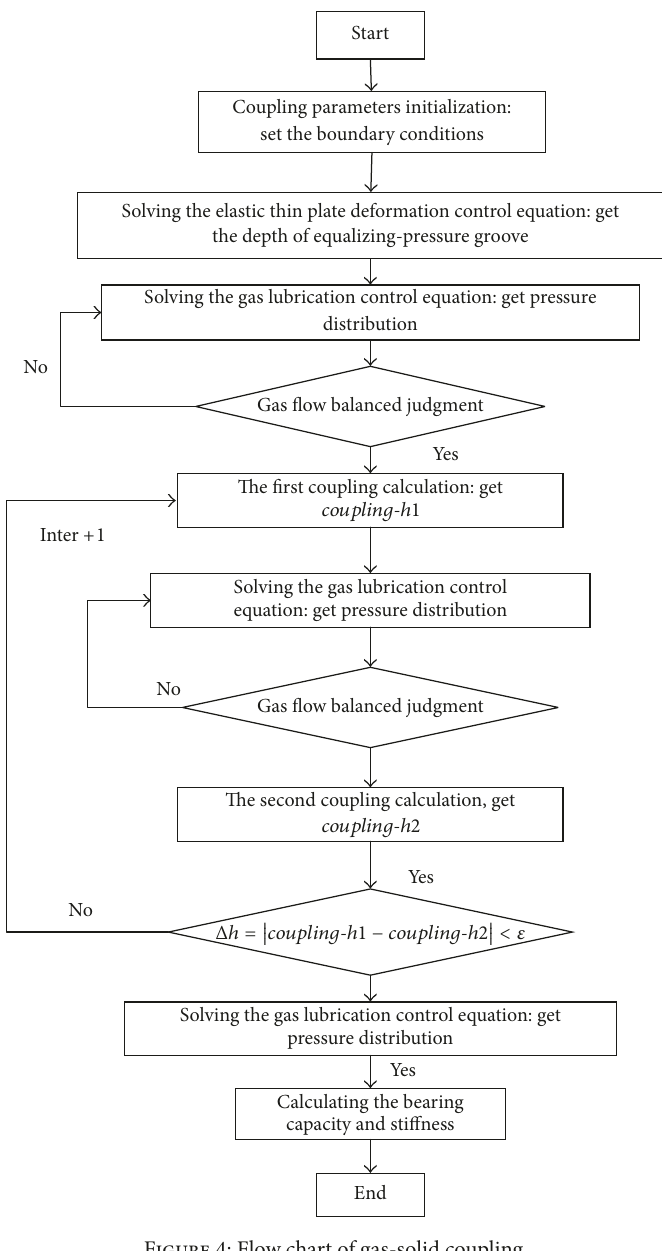
Figure 4: Flow chart of gas-solid coupling.